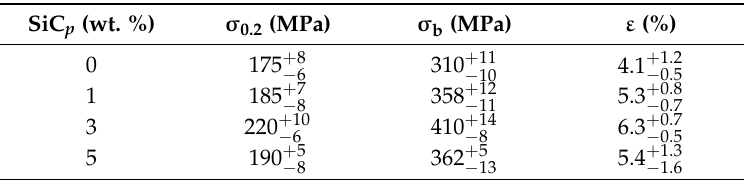
Figure 4. Tensile stress–strain curves of the cast Al–Cu alloy and nano-sized SiC p /Al–Cu composites with different SiC p contents. Table 1. Tensile properties of the as-cast Al–Cu alloy and nano-sized SiC p /Al–Cu composites with different SiC p contents.